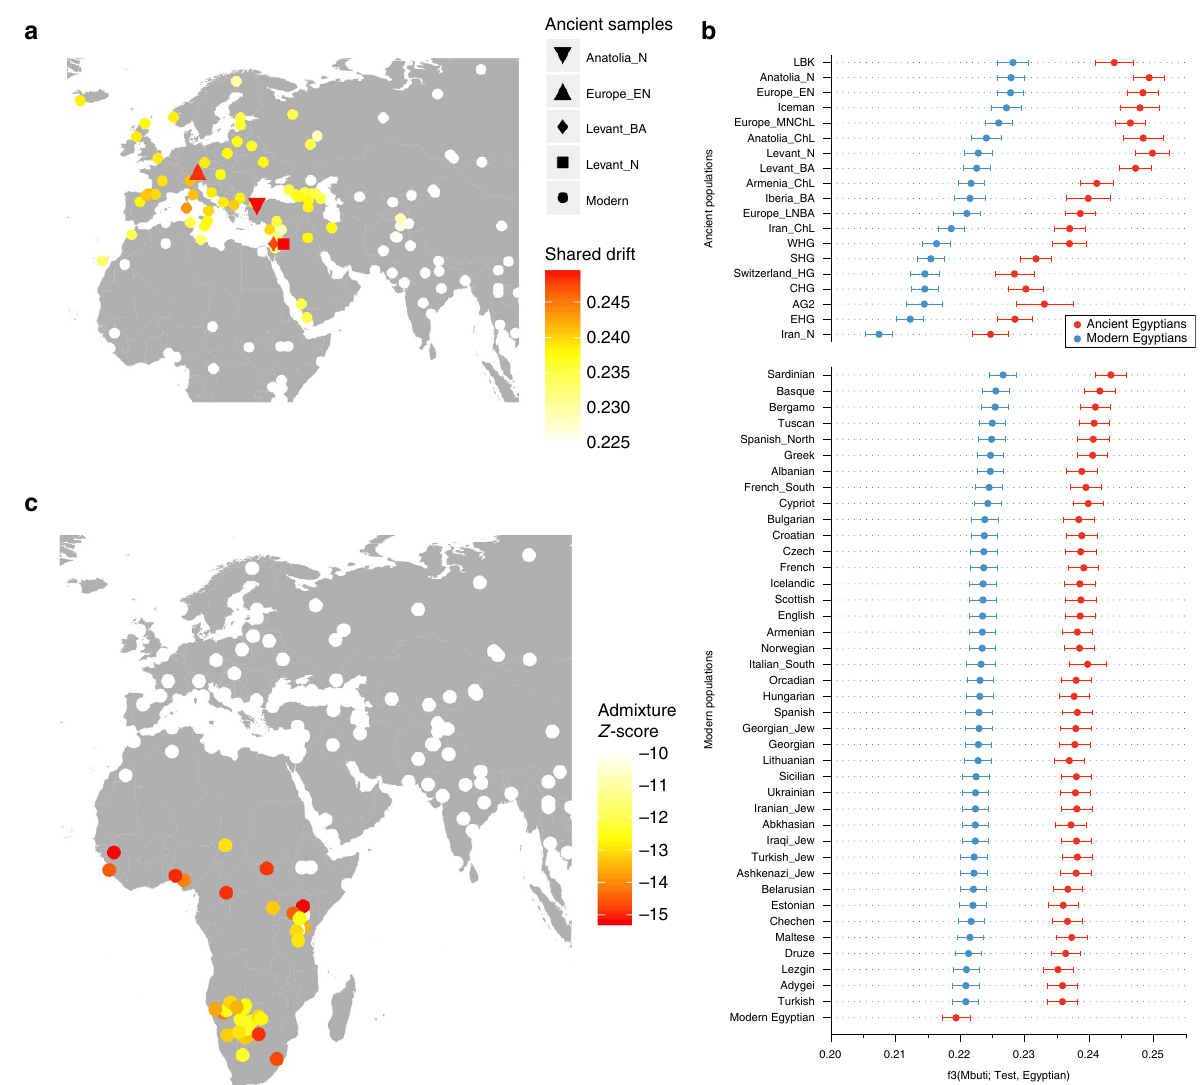
Figure 5 | Shared drift and mixture analysis of three ancient Egyptians with other modern and ancient populations. ( a ) Outgroup f 3 -statistics measuring shared drift of the three ancient Egyptian samples and other modern and ancient populations, ( b ) The data shown in a , compared with the same estimates for modern Egyptians, ordered by shared drift with modern Egyptians, ( c ) Admixture f 3 -statistics, testing whether modern Egyptians are mixed from ancient Egyptians and some other source. The most negative Z -scores indicate the most likely source